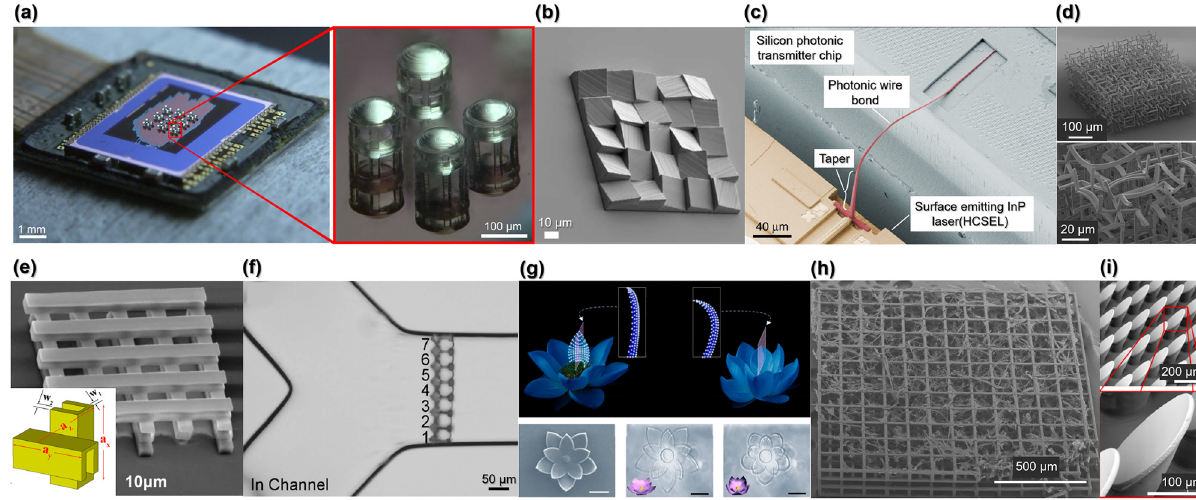
Figure 11: Examples of applications. (a) – An array of micro-objectives on CMOS chip. Reprinted with permission from [245]. (b) – SEM image of 3D printed DOE (prism